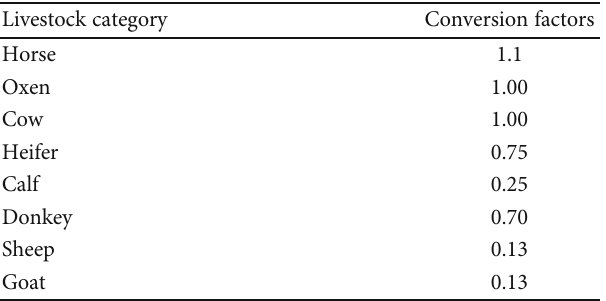
Table 7: Conversion factor used to estimate tropical livestock unit